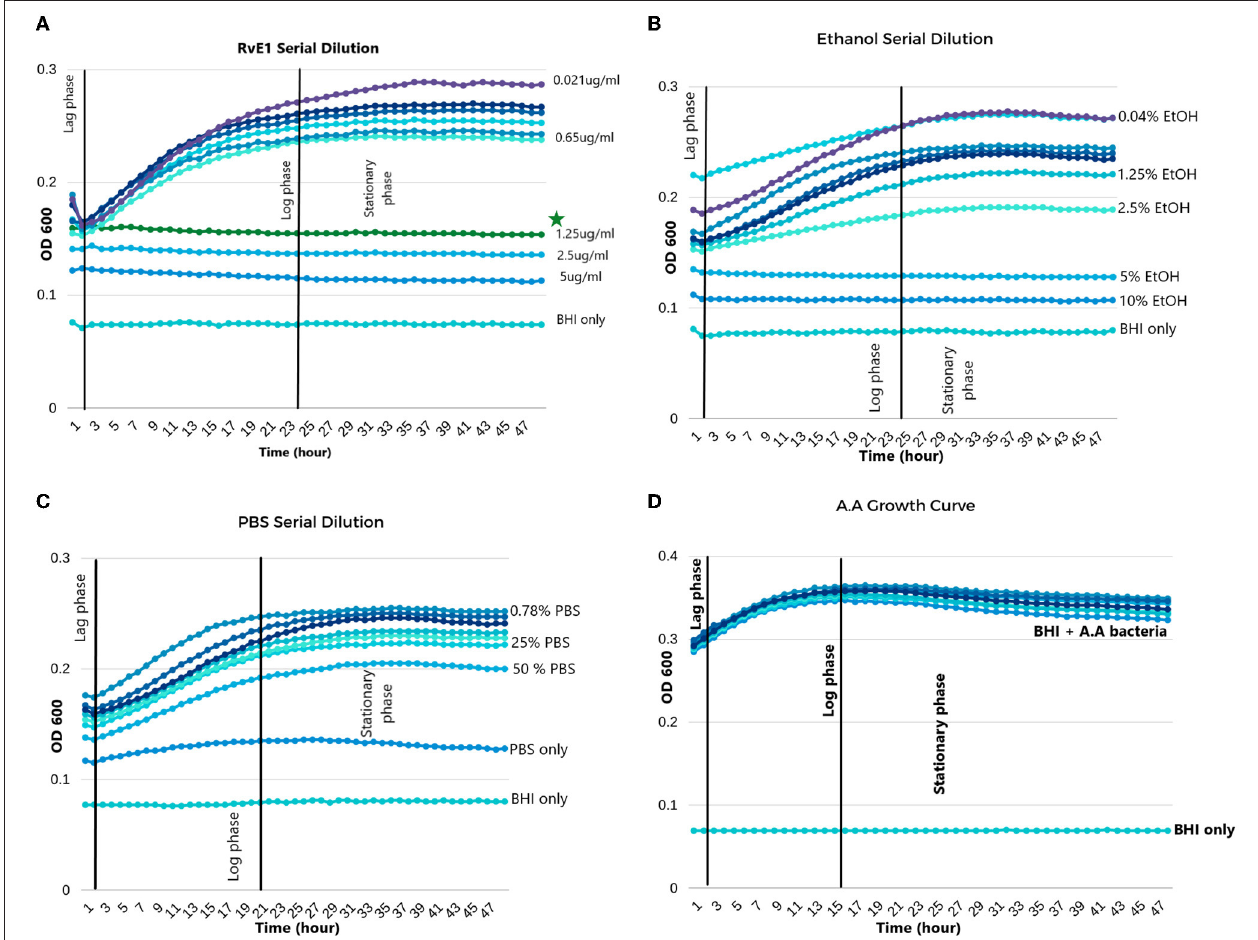
FIGURE 2 | Aggregatibacter actinomycetemcomitans growth in different solutions. (A) Serial dilution of Resolvin E1 diluted in BHI broth; minimum inhibitory concentration (MIC) was 1.25 µ g/ml. (B) Serial dilution of ethanol diluted in BHI broth; MIC was 5%. (C) Serial dilution of PBS diluted in BHI broth showed growth in all dilutions except for the PBS without BHI broth. (D) Growth curve of A. actinomycetemcomitans in BHI broth without any dilutions. *The symbol indicates the MIC of